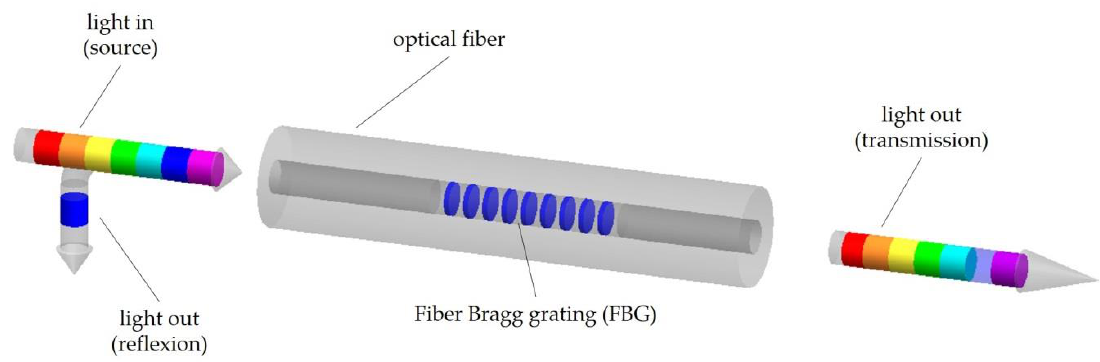
Figure 1. Schematic of a Bragg grating structure.